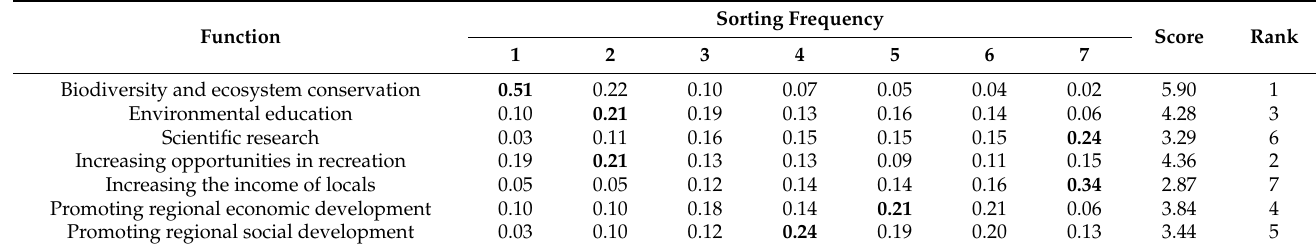
Table 2. Ranking of various functions of Wuyishan National Park.